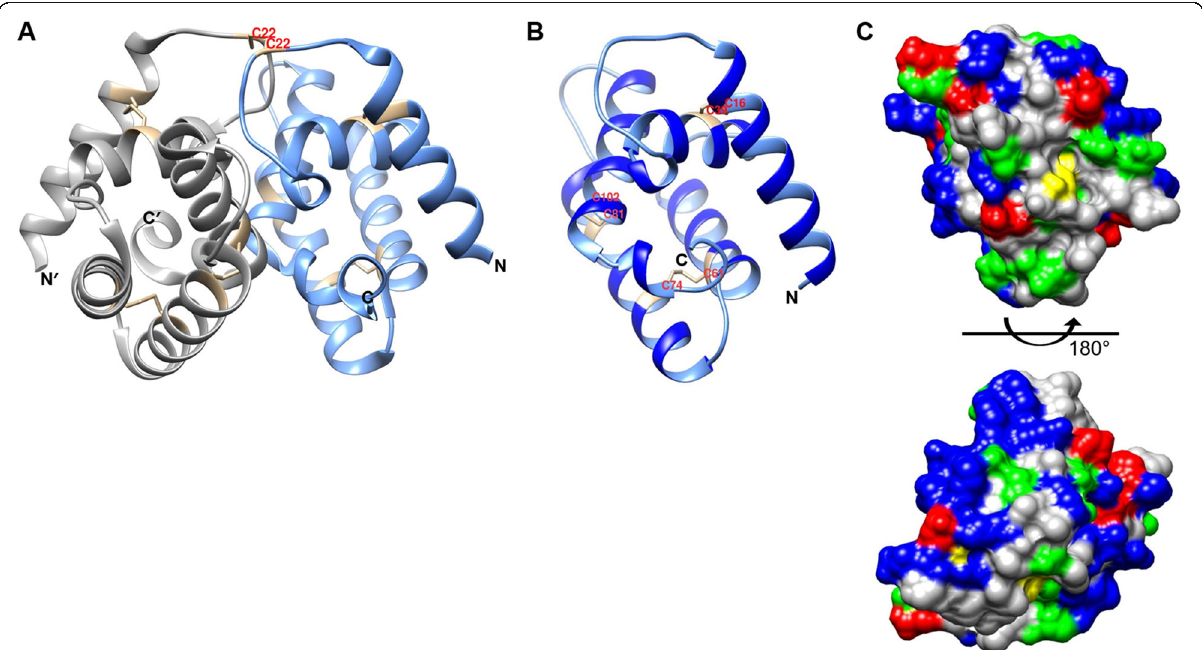
Fig. 5 A ribbon diagram of the three-dimensional model of the predicted structure of the Sol g 4.1 protein constructed using S. invicta venom allergen Sol i 2 dimer (PDB accession no. 2ygu) as a template. The disulfide bonds are highlighted in tan. a Structural features of the Sol i 2 template dimerized by a disulfide bond on symmetrical residues Cys22. b The three-dimensional homology model of the predicted structure of the Sol g 4.1 protein revealed a structure stabilized by three disulfide bonds, and the molecular view is the same as the view shown for the right molecule in A. c The surface of Sol g 4.1 is marked according to amino acid residue properties: red – acidic residues; blue – basic residues; gray – apolar residues; green – polar residues; and yellow – aromatic residues. The molecule in the top view is the same as the molecule shown in B and has been rotated by 180° along the horizontal axis to show the bottom view. The model was obtained using Swiss-Model and was visualized with UCSF